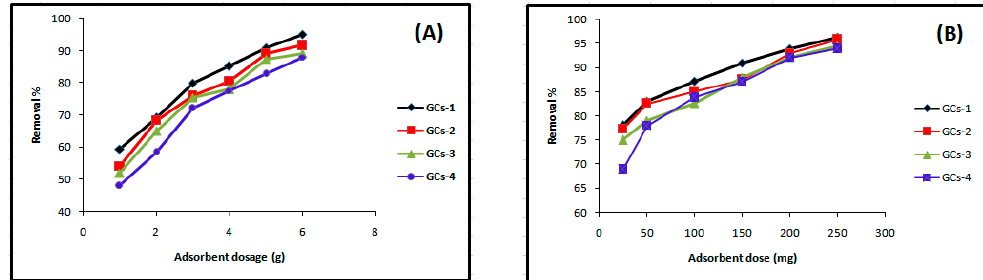
Figure 2. Influence of GCs amount on ( A ) nickel and ( B ) copper sorption.